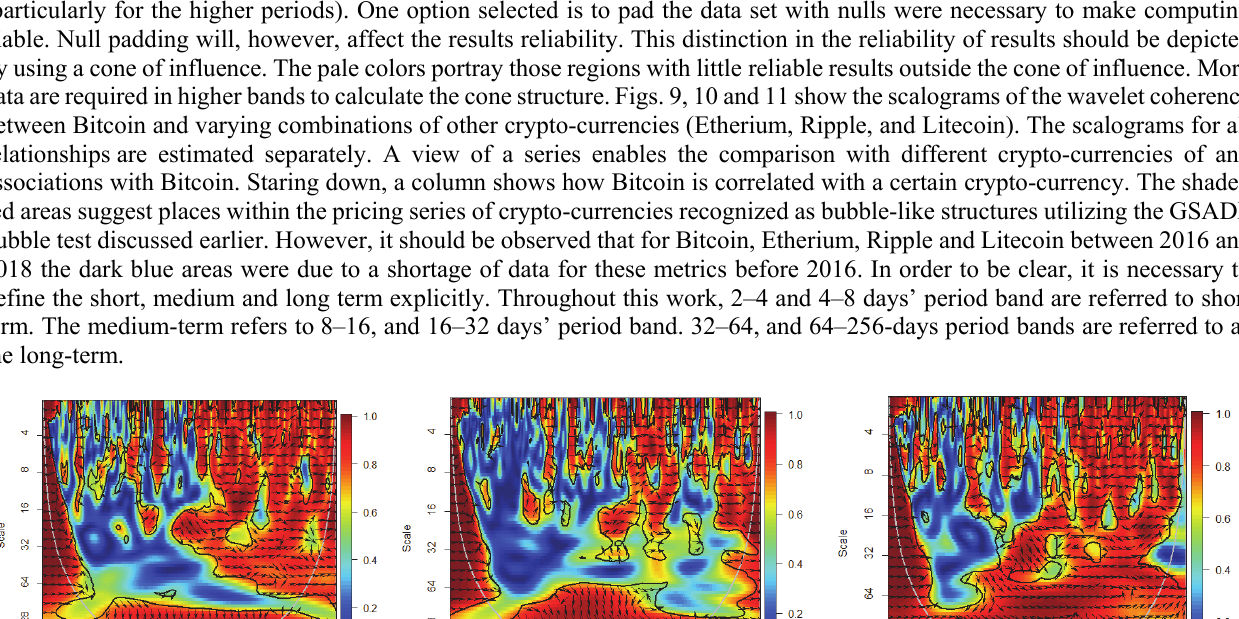
Fig. 10. Wavelet Coherence between Bitcoin and Ripple